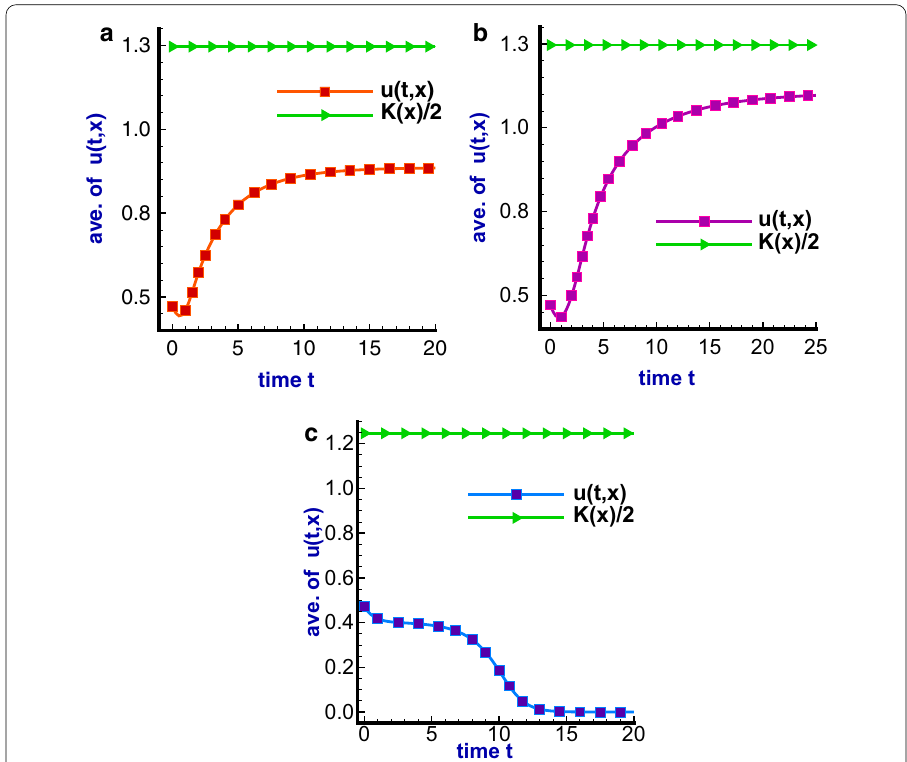
50 for diffusion coefficients a d = 1.2 cos (π x ) and r ( x ) = +